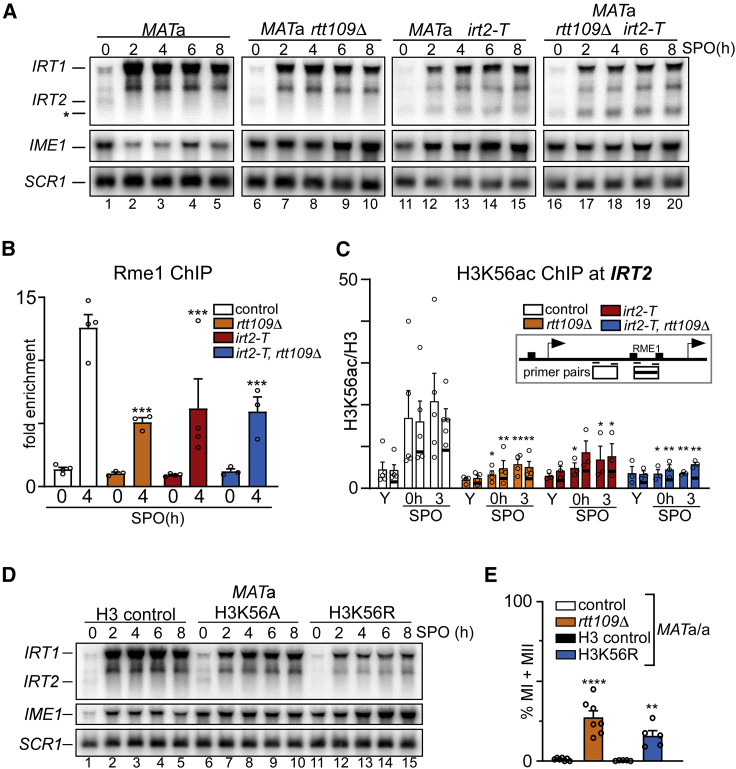
IRT2 transcription directs histone H3 lysine 56 acetylation to chromatin locally to activate IRT1 transcription(A) Expression of IRT1, IRT2, and IME1 in MATa WT (FW1509), rtt109Δ (FW4077, lanes), irt2-T (FW3596), and rtt109Δ, irt2-T double-mutant (FW4072) cells.(B) ChIP of Rme1-V5 at the IRT1 promoter in strains described in (A) but harboring the RME1-V5 allele (FW4031, FW3128, FW4075, and FW4073). Error bars represent ±SEM; n = 4, except for rtt109Δ and irt2-T rtt109Δ (n = 3). ∗∗∗p < 0.0005, two-way ANOVA followed by Fisher’s LSD test.(C) Histone H3 lysine 56 acetylation (H3K56ac) levels in the IRT1 promoter as measured by ChIP in control (MATa, FW1509) and irt2-T (FW3596) cells. H3K56ac ChIP signals were normalized to histone H3. As control, rtt109Δ and irt2-T rtt109Δ cells (FW4077 and FW4072) were included. Error bars represent ±SEM; n = 5 for control, n = 4 for rtt109Δ, and n = 3 for irt2-T and irt2-T rtt109Δ. ∗p < 0.05; ∗∗p < 0.005, two-way ANOVA followed by Fisher’s LSD test performed on each primer pair individually.(D) IRT1, IRT2, and IME1 expression in the MATa histone H3 control (FW5102), H3K56A (FW5113), and H3K56R (FW5116) cells.(E) MATa/a diploid cells harboring rtt109Δ or H3K56R and matching controls (FW15, FW4557, FW7413, and FW7417). DAPI masses were counted from cells fixed at 72 h in SPO. Cells harboring >2 DAPI masses were considered to have undergone meiotic divisions (MI + MII). Error bars represent ±SEM; n = 7 for control and rtt109Δ, and n = 5 for H3 control and H3K56R. ∗∗p < 0.005; ∗∗∗∗p < 0.0001, on an unpaired parametric two-tailed Student t test comparing mutant with respective control.